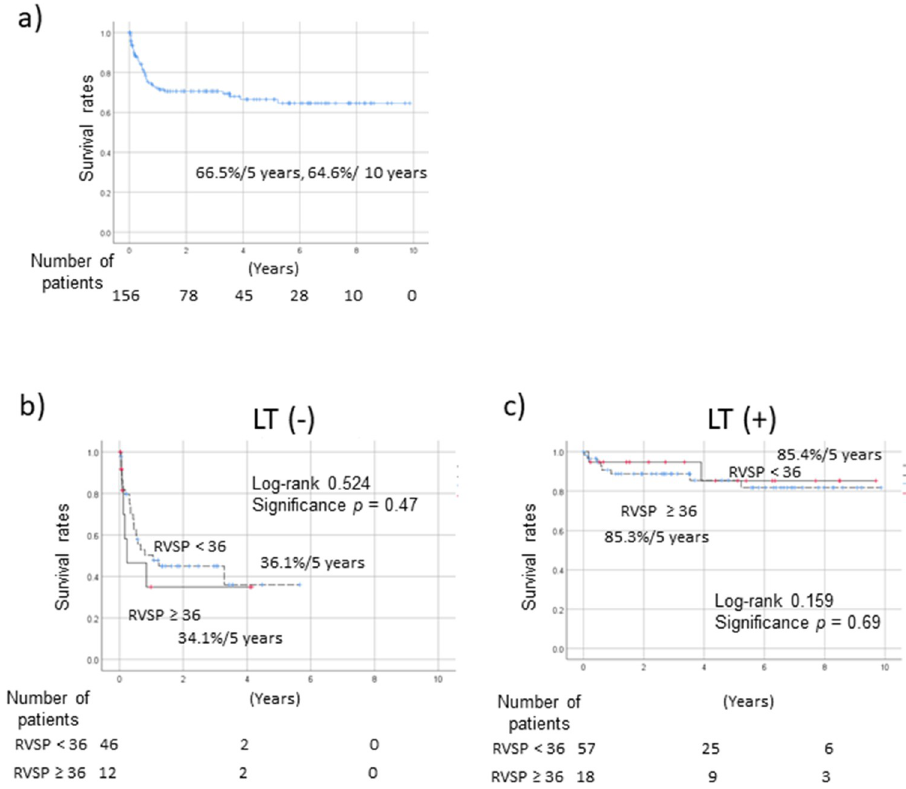
Fig 3. Mortality rates of cirrhotic LT candidates. (a) All patients and patients with RVSPs of < 36 and � 36 mmHg (b) without LT and (c) with LT. The 5- and 10-year survival rates in cirrhotic LT candidates were 66.5% and 64.6%, respectively (a). About survival rate according to RVSP in LT and non-LT cases, in non-LT cases, the 5-year survival rates were 36.1% and 34.1% in those with RVSPs of < 36 and � 36 mmHg, respectively ( p = 0.47) (b). In LT cases, the 5-year survival rates were 85.4% and 85.3% in those with RVSPs of < 36 and � 36 mmHg, respectively ( p = 0.69) (c). LT, liver transplantation; RVSP, right ventricular systolic pressure.